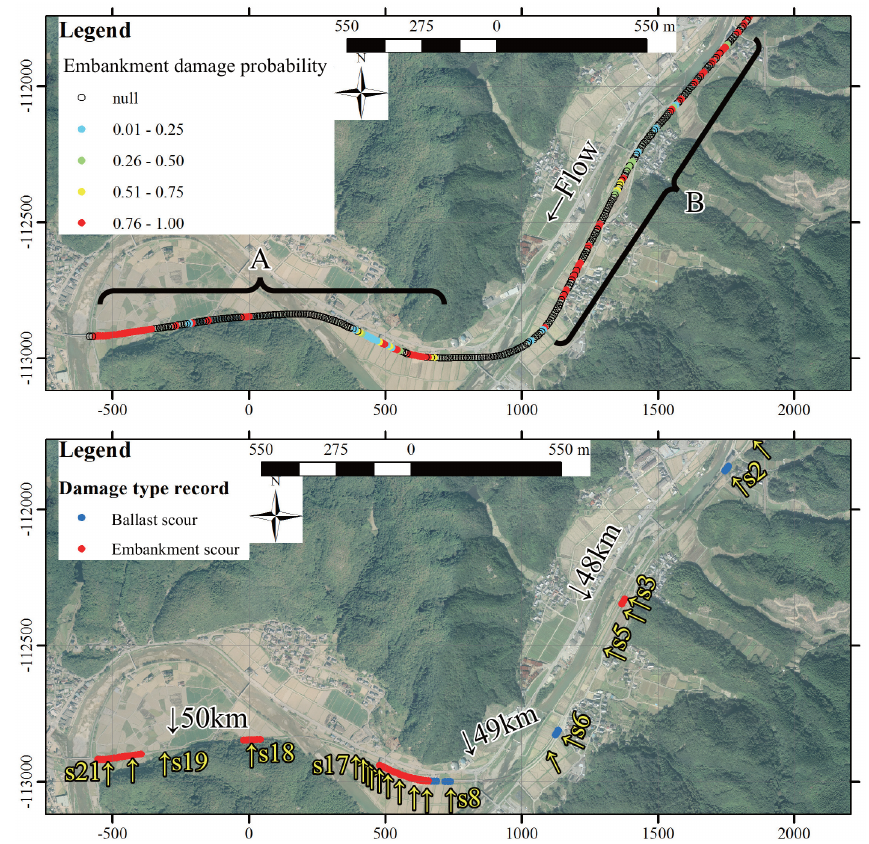
Figure 15. Estimated damage probability (top) and damage type record (bottom) at Sayo River section S. The yellow symbols in the bottom figure depict data points listed in Table A2. (Source: Kinki Regional Development Bureau, Ministry of Land, Infrastructure, Transport and Tourism Japan for the aerial photo taken in 2010.)